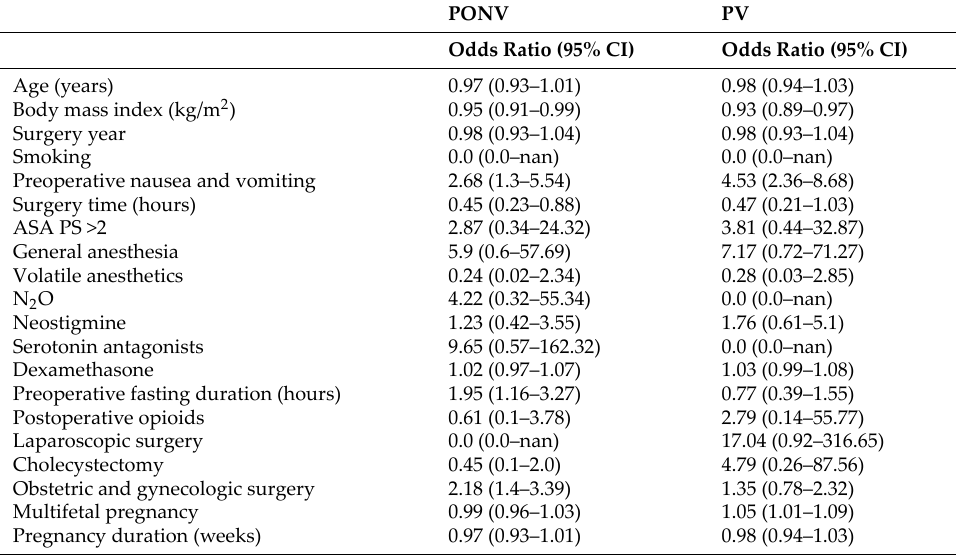
Table A3. Odds of developing PONV and PV in pregnant women who underwent nondelivery surgery.